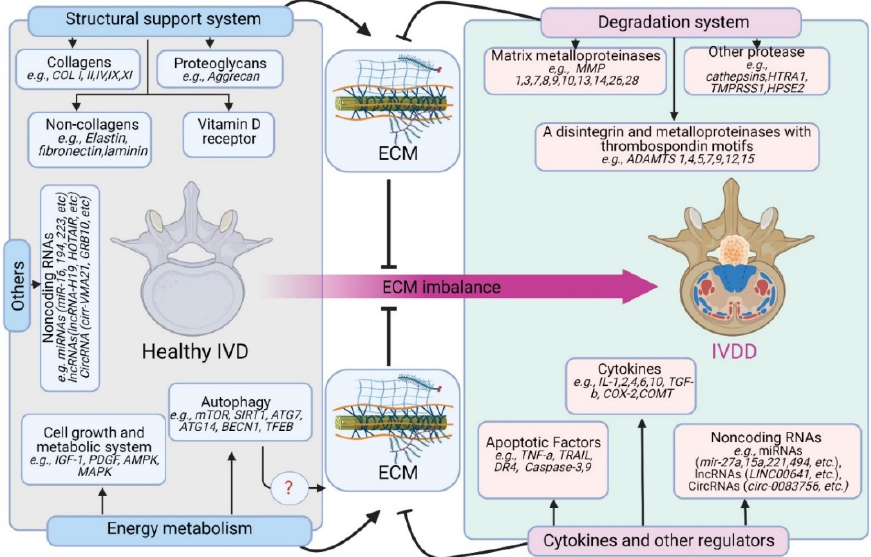
Figure 2. IVDD-associated genes. Mutations in IVD genes, such as structural proteins (e.g., collagens, proteoglycans, and others) and degradation enzymes (e.g., MMPs, ADAMTS, and others) in the pathophysiology of IVDD associating with extracellular matrix (ECM) homeostasis. Many other are involved in the pathophysiology of IVDD associating with extracellular matrix (ECM) gene products such as cytokines, apoptotic factors, as well as noncoding RNAs are associated with homeostasis. Many other gene products such as cytokines, apoptotic factors, as well as noncoding IVDD progression. Alterations in autophagy and energy metabolism genes facilitate the progression RNAs are associated with IVDD progression. Alterations in autophagy and energy metabolism of IVDD, although their underlying mechanisms are not genes facilitate the progression of IVDD, although their underlying mechanisms are not clear.